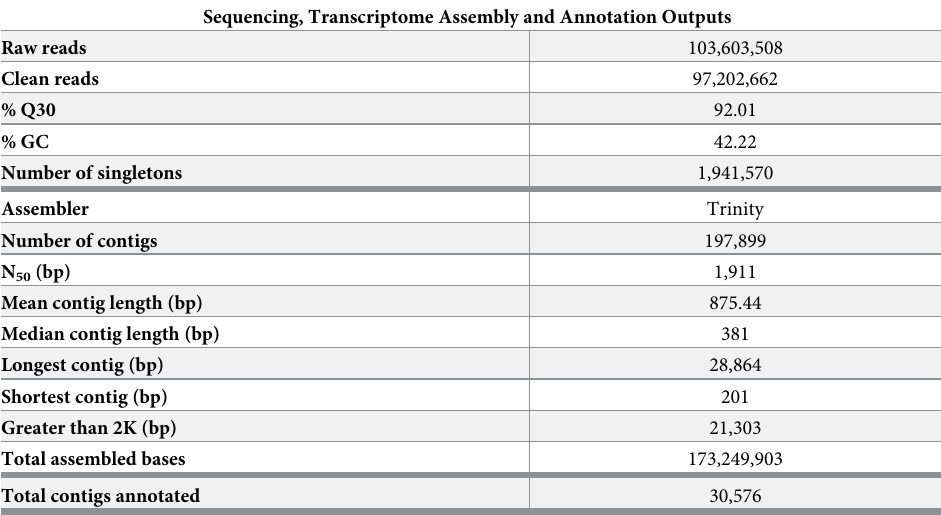
Table 1. Statistics of M . carcinus RNA sequencing, transcriptome assembly and annotation. Sequencing, Transcriptome Assembly and Annotation